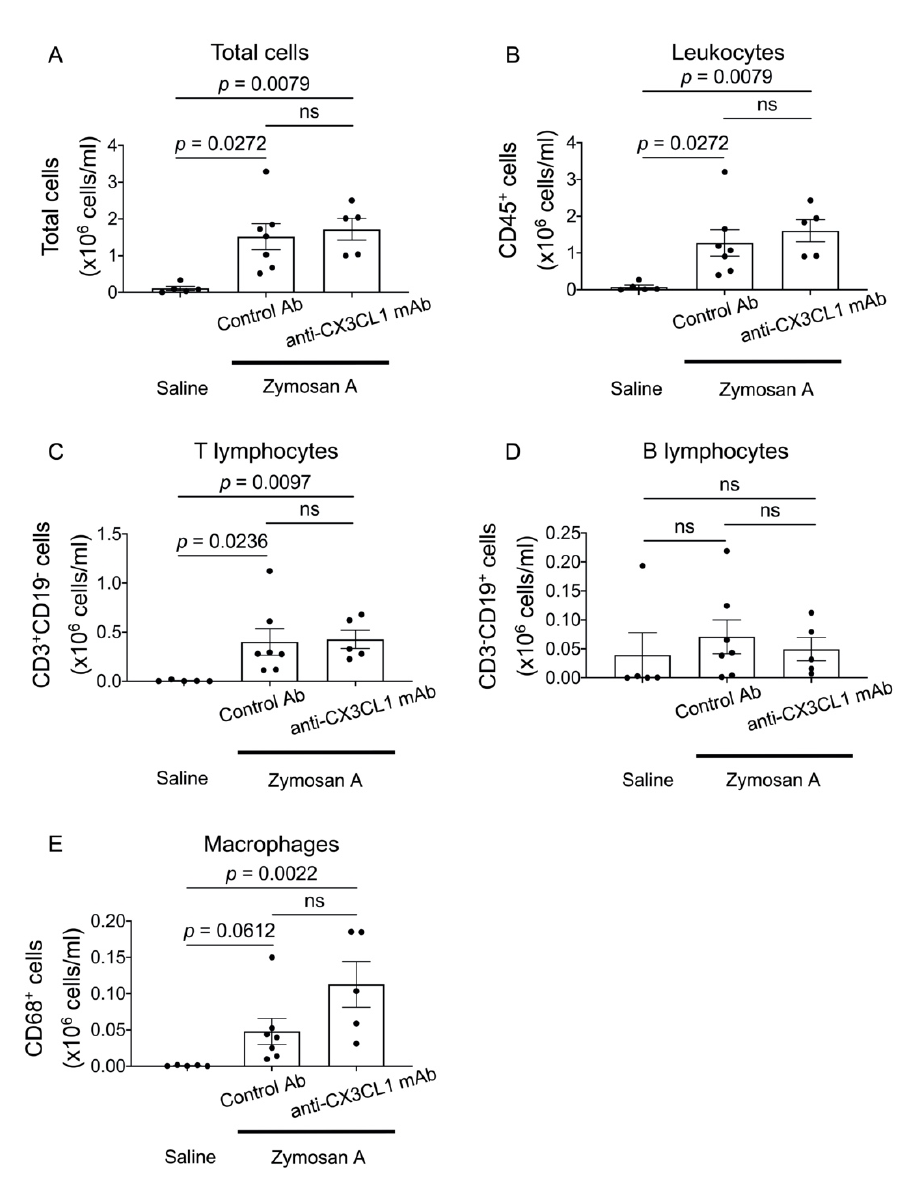
Figure 4. No significant changes in numbers of individual immune cell populations in BALF from SKG-ILD mice treated with anti-CX3CL1 mAb. BALF cells were isolated from saline-administered SKG mice ( n = 5) or zymosan A-administered SKG mice treated with control Ab ( n = 7) or anti- CX3CL1 mAb ( n = 5). The numbers of all cells ( A ), CD45 + cells ( B ), T lymphocytes ( C ), B lymphocytes ( D ), and macrophages ( E ) are shown. Since 4 mL of saline was used to obtain BALF, total cell numbers of individual populations are estimated by multiplying the concentration (cells/mL) by 4 mL.